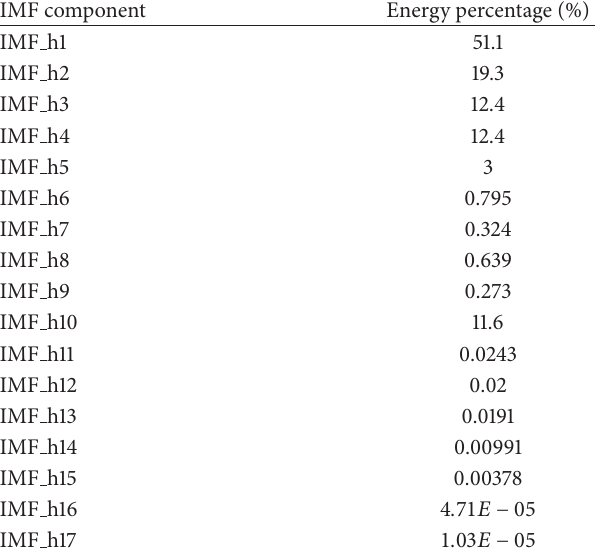
Table 13: IMF component percentage of energy of original micro- seism signals by EEMD in working condition 29.